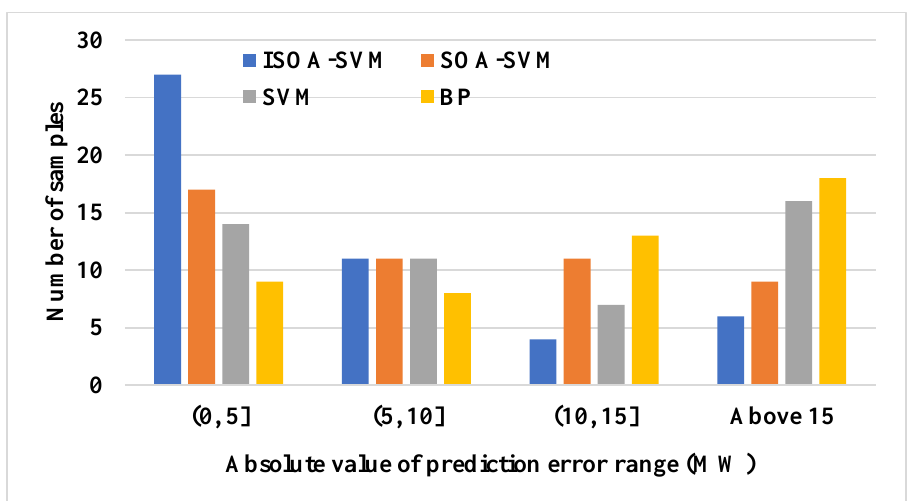
Figure 6. Power load error of four forecasting models for Case 2.